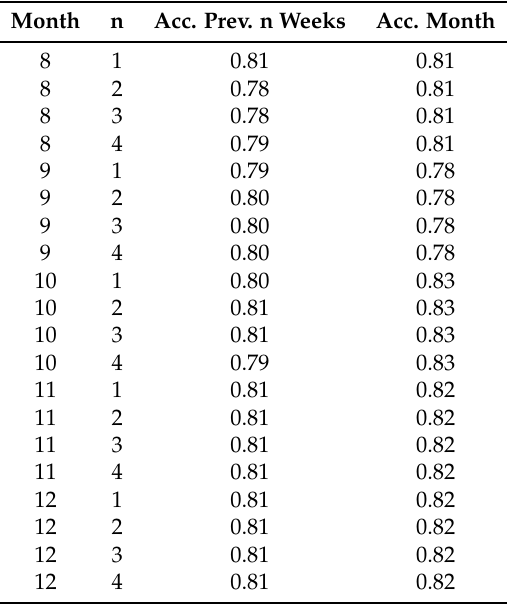
Table 2. Means of the accuracy scores obtained applying patterns calculated with the previous n week data, and patterns obtained